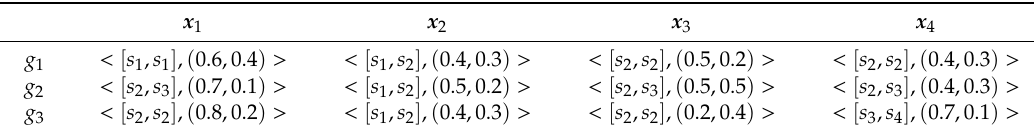
Table 2. Decision matrix A ( 2 ) with IULNs.